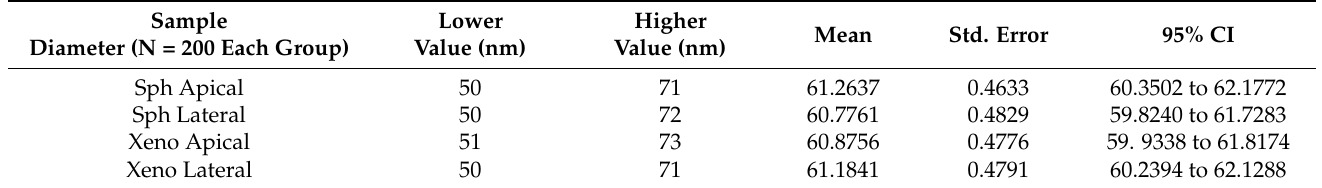
Table 2. Summary statistic of diameter values in apical-secreted and basolateral-secreted exosomes, in MTSs and xenograft.